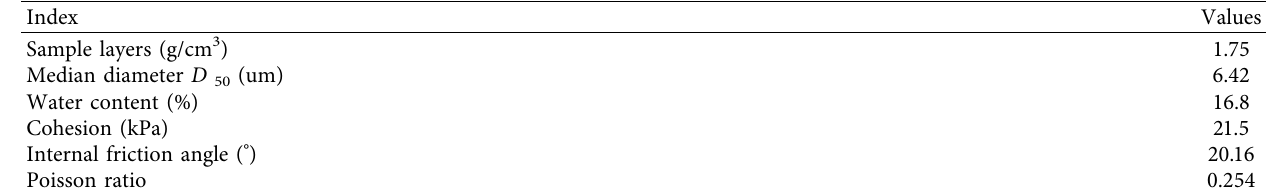
Table 2: Physical and mechanical parameters of test